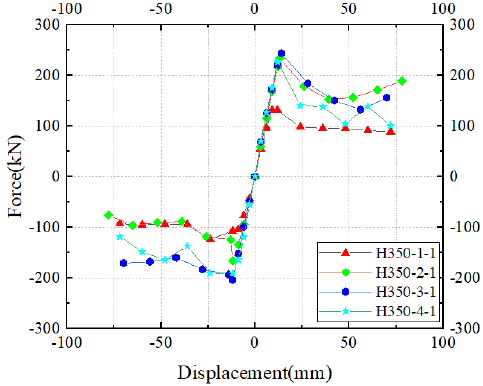
Figure 14. Force − displacement skeleton curves.